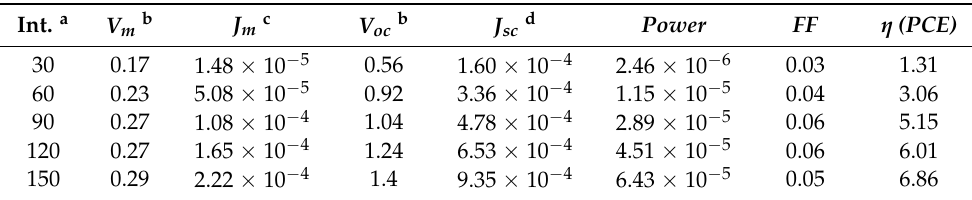
Table 6. I–V parameters and photovoltaic parameters of the Au/[PPy/MWCNTs] composites/n- Si/Al solar cell under different illumination intensities P in